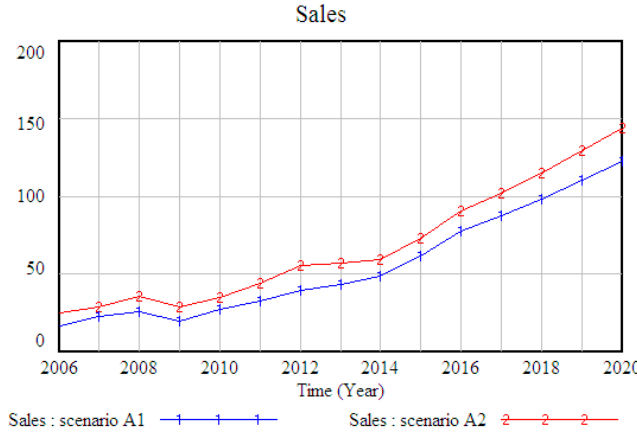
Figure 2. Sales of natural gas (billion cubic meters).